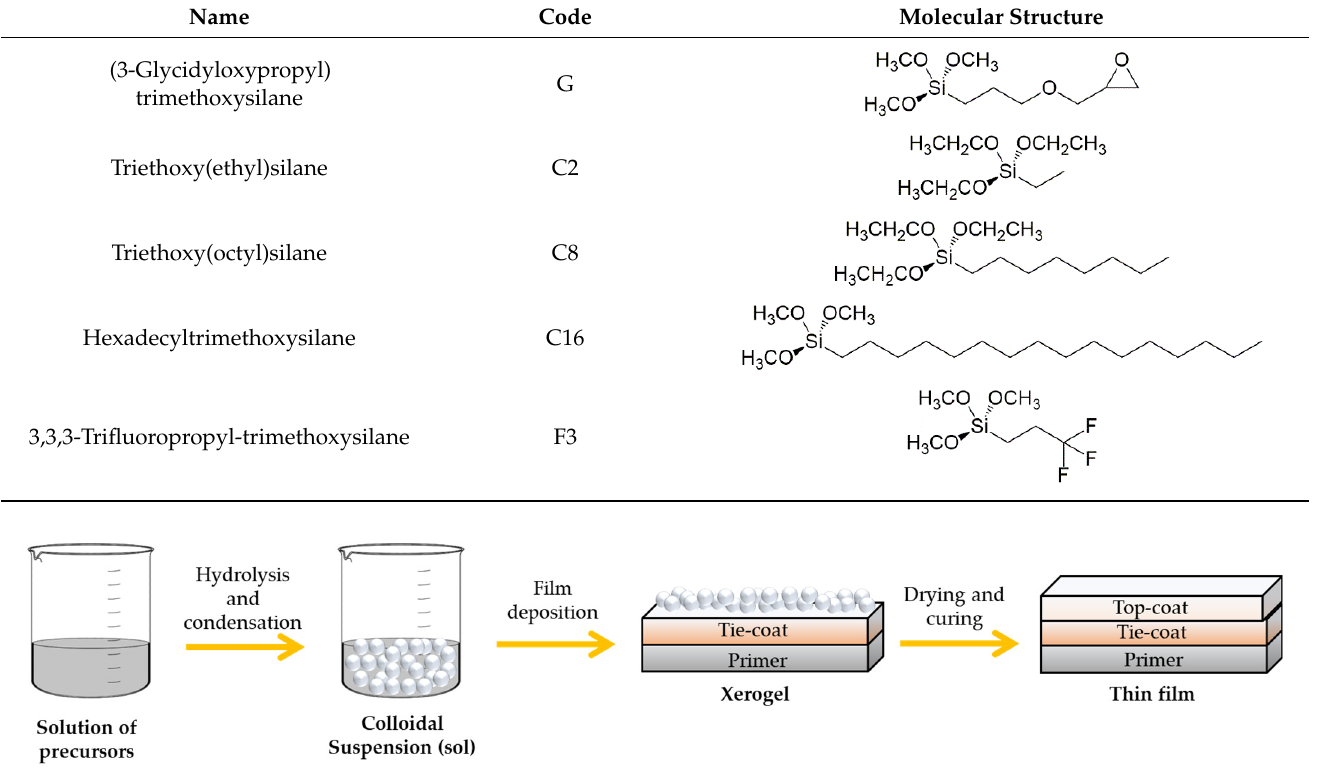
Figure 2. Subsequent stepwise sol-gel process for functional coating fabrication.